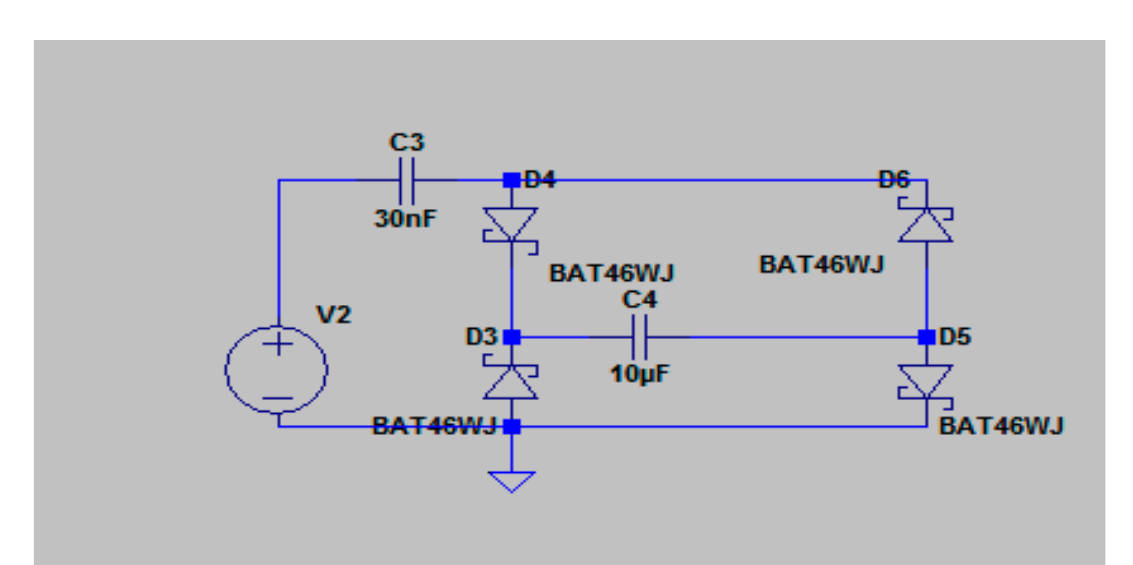
Figure 2. Schematic Illustration of Equivalent Circuit Model.